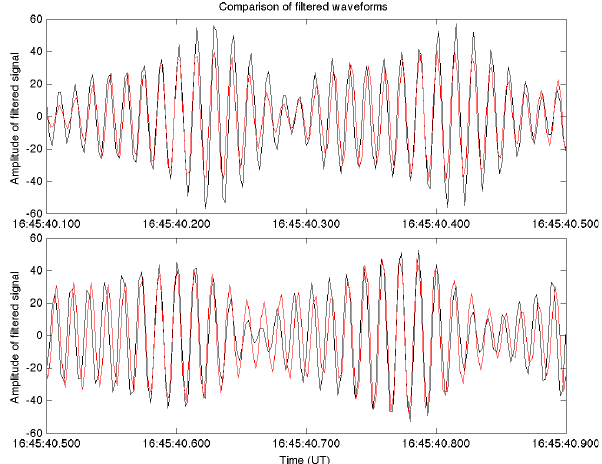
Fig. 5. The ω − k dispersion function calculated using Cluster 2 data with a time offset of 600ms.